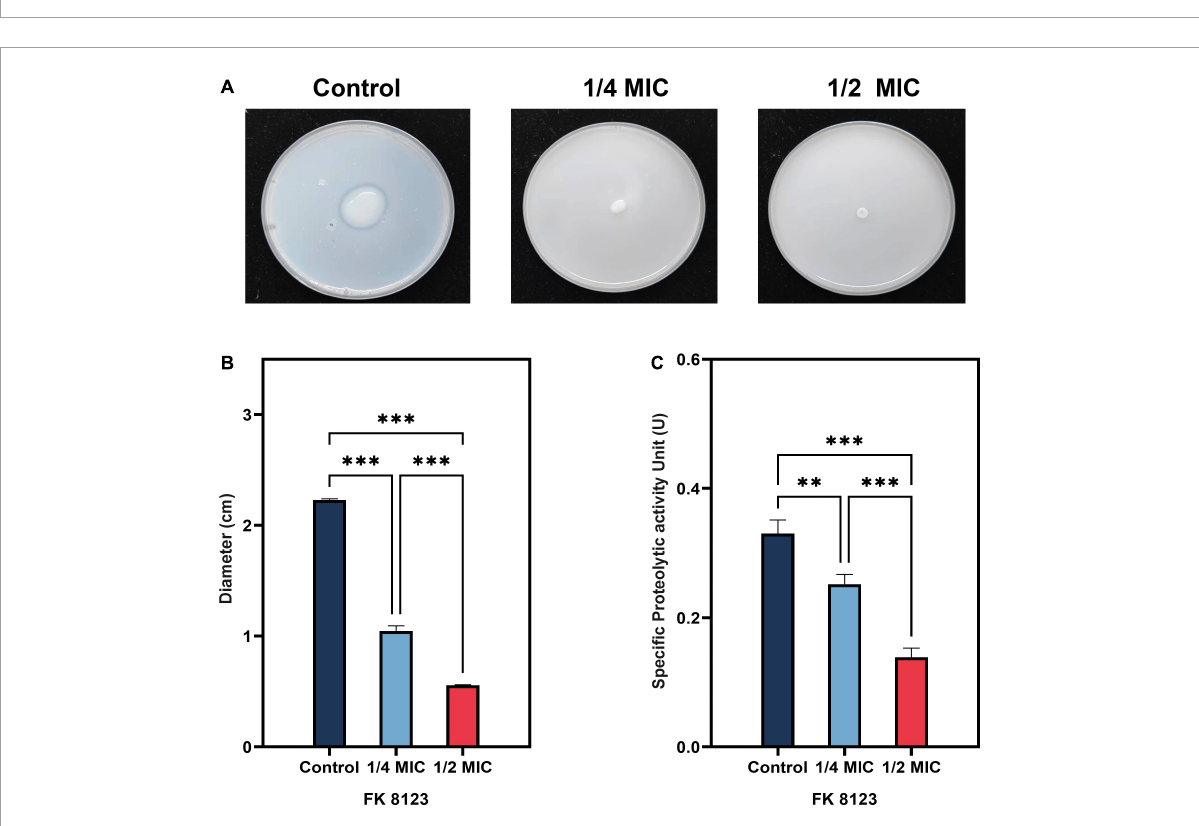
FIGURE3 Protease inhibition assay. (A) Milk agar containing a series of concentrations of chlorogenic acid (CA) [1/2 and 1/4 minimum inhibitory concentration (MIC)] supplemented with carbapenem-resistant Klebsiella pneumoniae (CRKP); (B) Average diameter of five CRKP isolates; (C) Specific protease activity unit. The “ ∗∗ ” means P < 0.01, “ ∗∗∗ ” means P < 0.001.